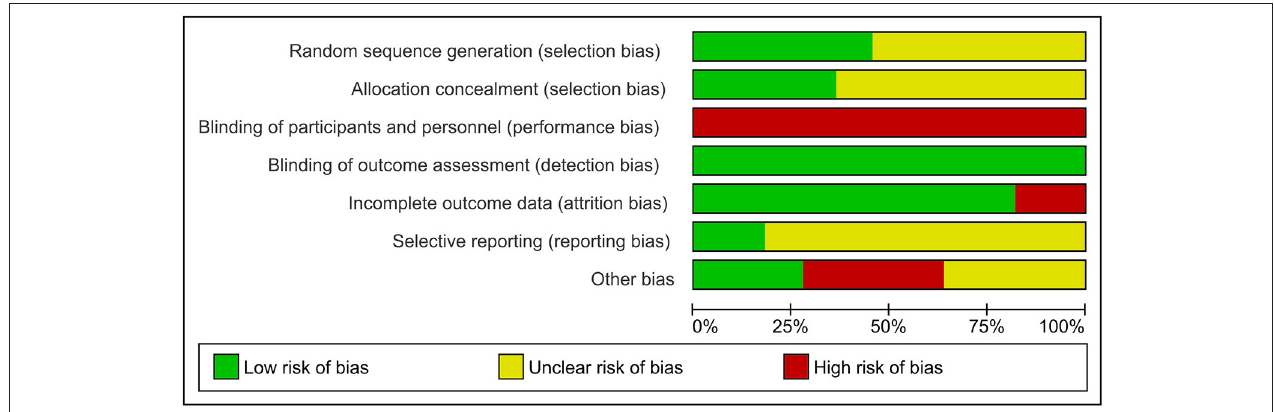
FIGURE 2 | Risk of bias graph for the primary outcome: the impact of whole, fresh fruit consumption on measures of body weight and adiposity in RCTs. Bars illustrate the proportion of trials that received a particular risk of bias score in each risk of bias domain.